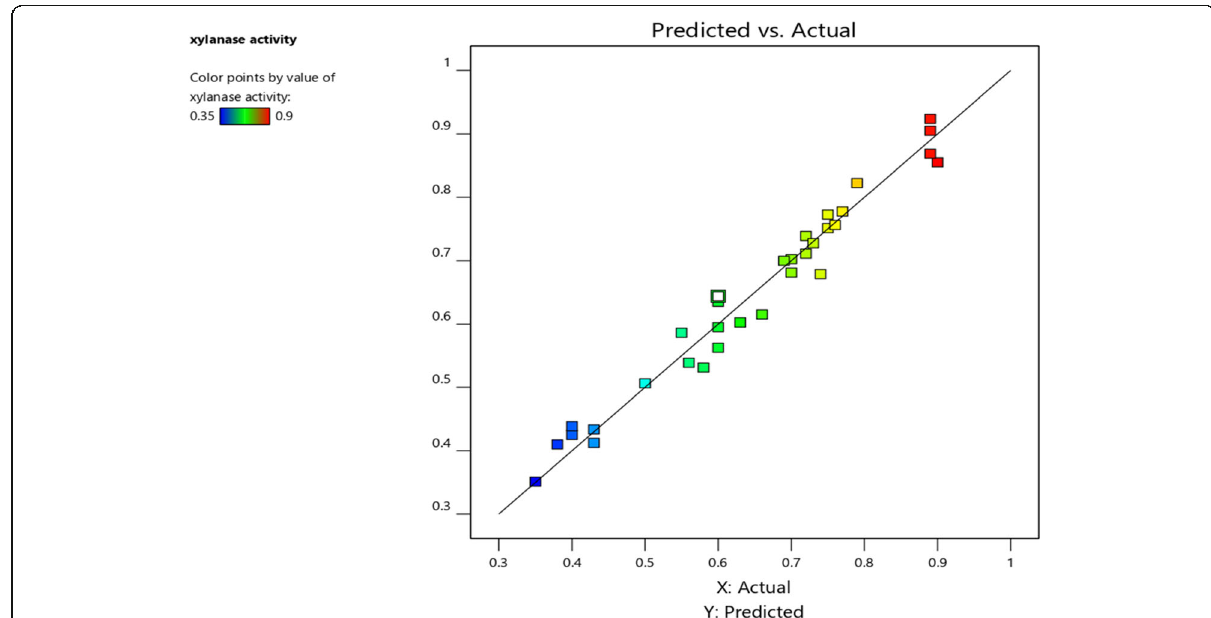
Fig. 4 Pareto chart showing the effect of medium components on xylanase activity by Aspergillus oryzae